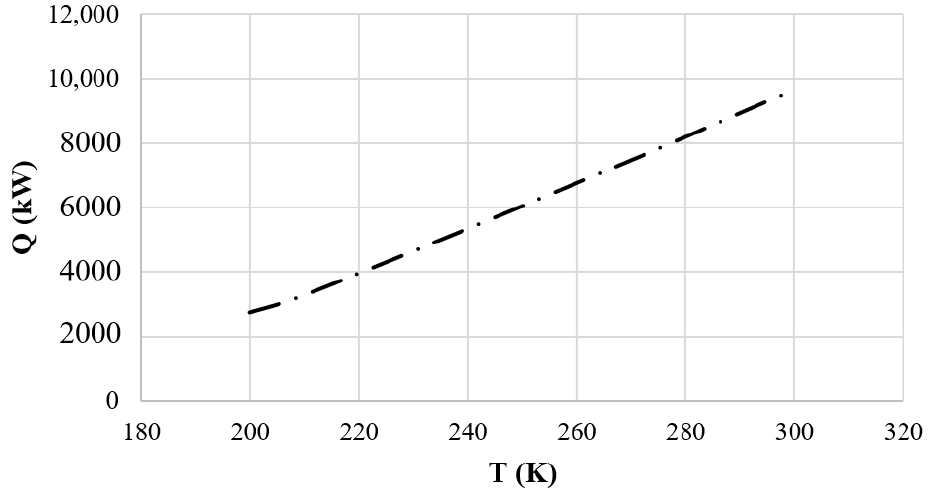
Figure 22. Energy required variation with temperature for